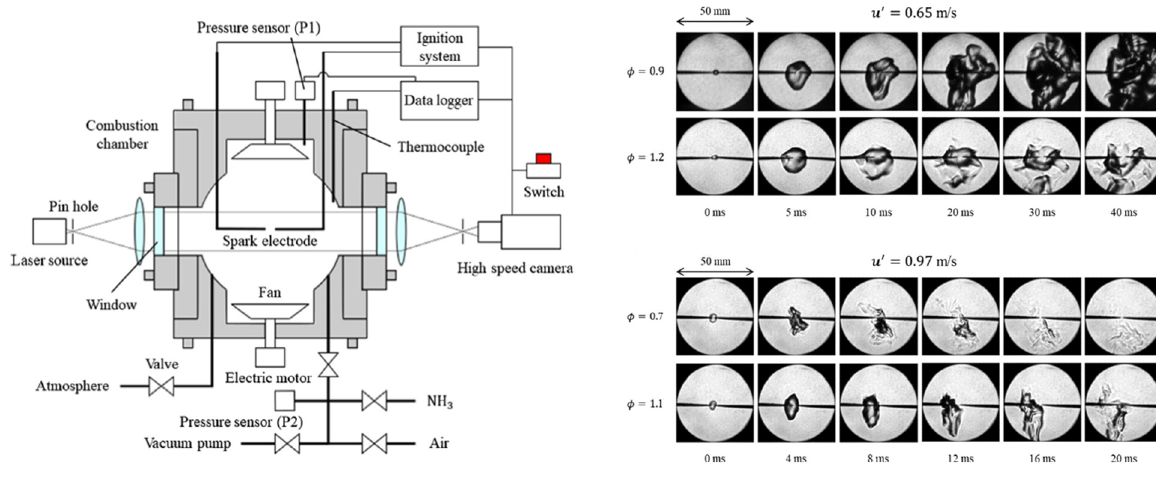
Figure 7. Experimental apparatus and results to investigate NH 3 -air combustion characteristics in a turbulent field: ( a ) Schematic of experimental apparatus; ( b ) Schlieren images of NH 3 -air mixture flame at each equivalence ratio and turbulence intensity. Courtesy of Elsevier